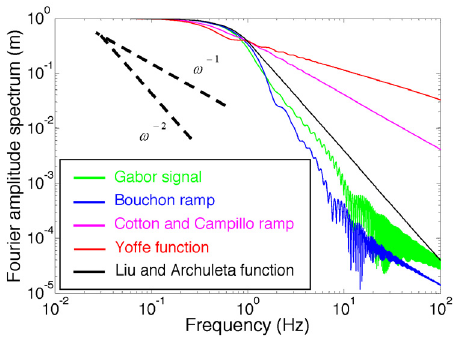
Figure 10. FAS of the time derivative of the STF adopted in the present study (namely the FAS of is reported; see Section 3 for fur- ther